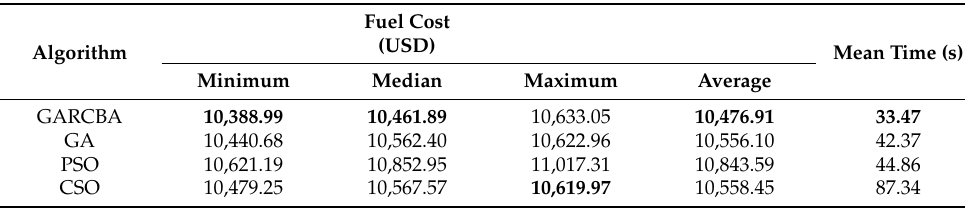
Table 6. Statistical results for Case 1.2 from 25